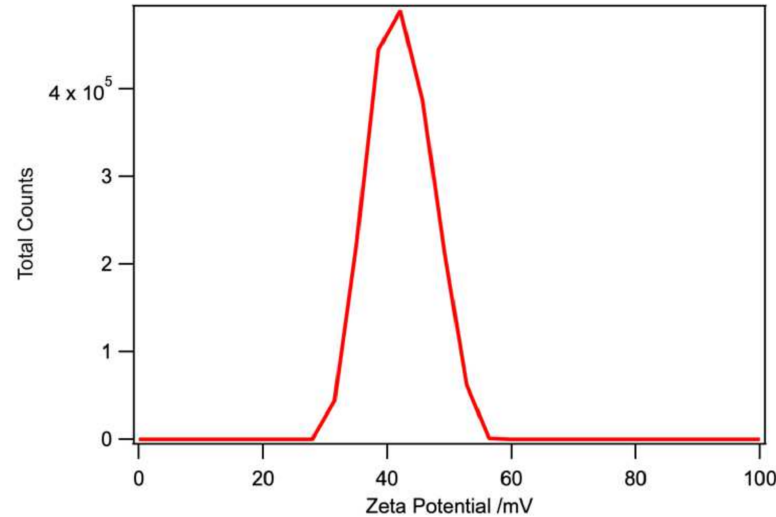
Figure 2. Zeta potential measured for por-Si coated with arginine after grinding for 4 h from a sample with a Z-average particle size of 230